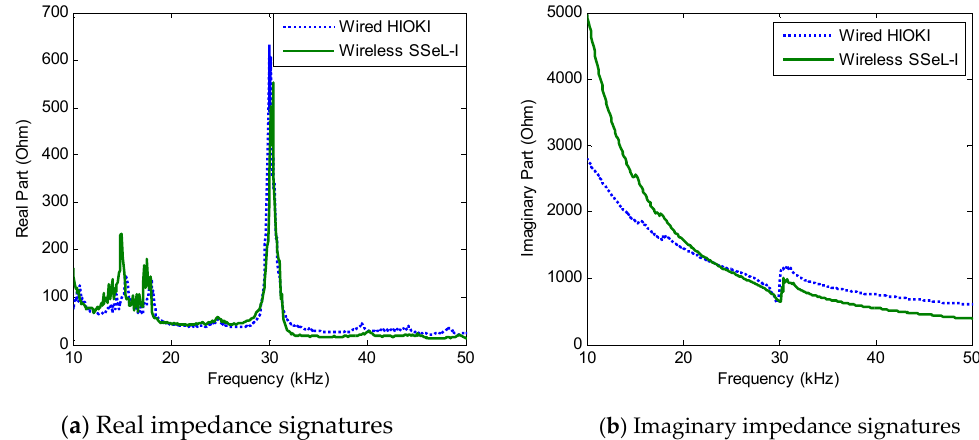
Figure 12. Impedance signatures in 10–50 kHz: wired versus wireless measurements.